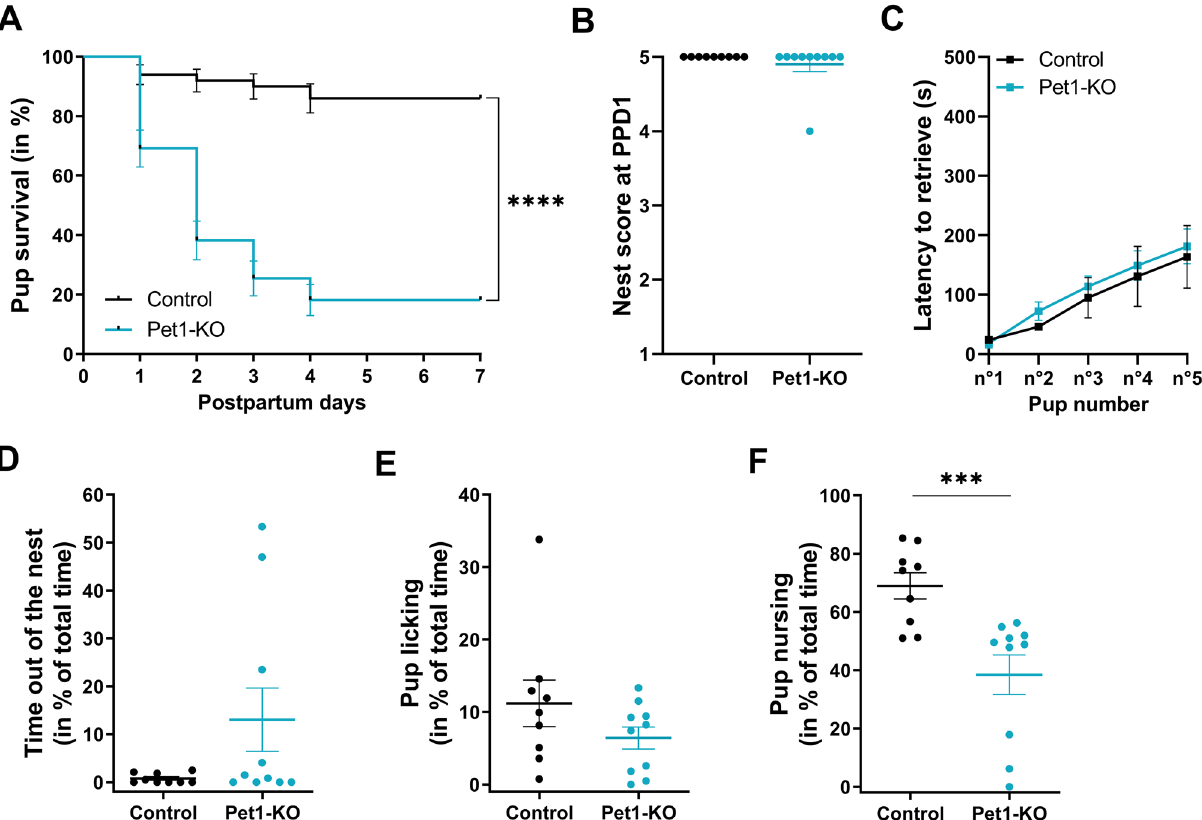
Figure 1. Reproductive success and nursing behavior are altered in primiparous Pet1-KO mothers. Nulliparous Pet1-KO and control (Pet1 +/− ) mice were mated to WT males. The number of litters analyzed was n = 11 for Pet1-KO dams and n = 10 for control dams. All litters were culled to 5 pups. ( A ) Survival of pups raised by Pet1-KO dams was strongly reduced; **** p < 0.0001 (mean ± SEM, Log-rank Mantel-Cox test). ( B ) Nest building was graded using the Deacon’s scale 29 from score 1 = untouched to score 5 = complete nest with high walls. Nest building score at PPD1 was similar between Pet1-KO and control dams (mean ± SEM, MW U = 40.50, p > 0.99). ( C ) Latency to retrieve 5 pups into the nest in seconds over a 10 min period. No difference in the latency to retrieve pups was found (Pet1-KO: n = 10; controls: n = 9) (mean ± SEM, repeated-measures two-way ANOVA: genotype x pup number interaction F 4,68 = 0.1862, p = 0.94; Genotype main effect F 1,17 = 0.2253, p = 0.64). ( D–F ) Maternal behavior was scored at PPD0 during 20 min observations. Time spent outside the nest ( D ) and pup licking activity ( E ) did not differ between Pet1-KO and controls, but Pet1-KO dams spent significantly less time nursing ( F ); *** p < 0.001 (mean ± SEM, Mann–Whitney from both groups were found to be infanticidal, and no signs of cannibalism were noted. Nest building behavior of Tph2-KO was altered compared to control dams. After delivery, the nests of Tph2-KO mothers were less high than those of controls (mean score: Tph2-KO: 4.1 ± 0.3 vs. controls: 5; MW U = 6, p = 0.02). At PPD1, the nests of Tph2-KO dams were graded 3.7 ± 0.5, contrasting with the high-walled nests of control dams (mean score: 5; MW U = 6, p = 0.02; Fig. 2B). Pups from Tph2-KO mothers were generally scattered around the nest, also indicating a defect in huddling (scored in Tph2-KO: 0.36 ± 0.09 vs. controls: 0.92 ± 0.08; MW U = 2.5, p = 0.004). In the pup retrieval assay, 42.8% (3/7) of the Tph2-KO dams collected no pup over the 10 min period. The remaining females retrieved up to 4 pups but with an increased latency compared to controls (two-way ANOVA: Genotype x pup number interaction F 3,31 = 7.83, p = 0.0005; Genotype main effect F 1,31 = 57.77, p < 0.0001; Fig. 2C). Monitoring maternal activity in the home cage showed that Tph2-KO mothers spent significantly more time outside the nest than controls (MW U = 7, p = 0.05, Fig. 2D). Pup licking activity of Tph2-KO and control dams in the nest was similar (Fig. 2E), but the time dedicated to nursing was significantly reduced (MW U = 7, p = 0.05; Fig. 2F). Overall, the evaluation of maternal behavior in these two mouse lines with constitutive reduction of 5-HT transmission, though of a different nature, showed some commonalities: both Tph2-KO and Pet1-KO dams showed poor survival of their litters and deficits in nursing behavior (supplementary Fig. 2) while other maternal behaviors were moderately altered in the Tph2-KO dams, but not in the Pet1-KO dams. In the absence of overt signs of maternal aggressive behaviors or of major changes of pup-directed behaviors such as nest building or pup licking, the defective crouching over pups thus appeared as the common feature explaining increased pup lethality.